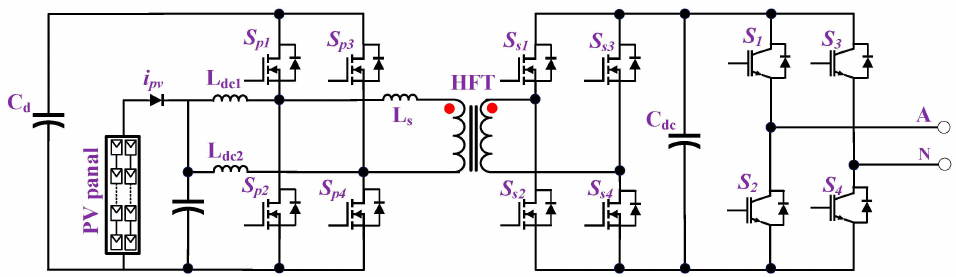
Figure 7. A single submodule of a CF-DAB converter with a CHB cell [57].